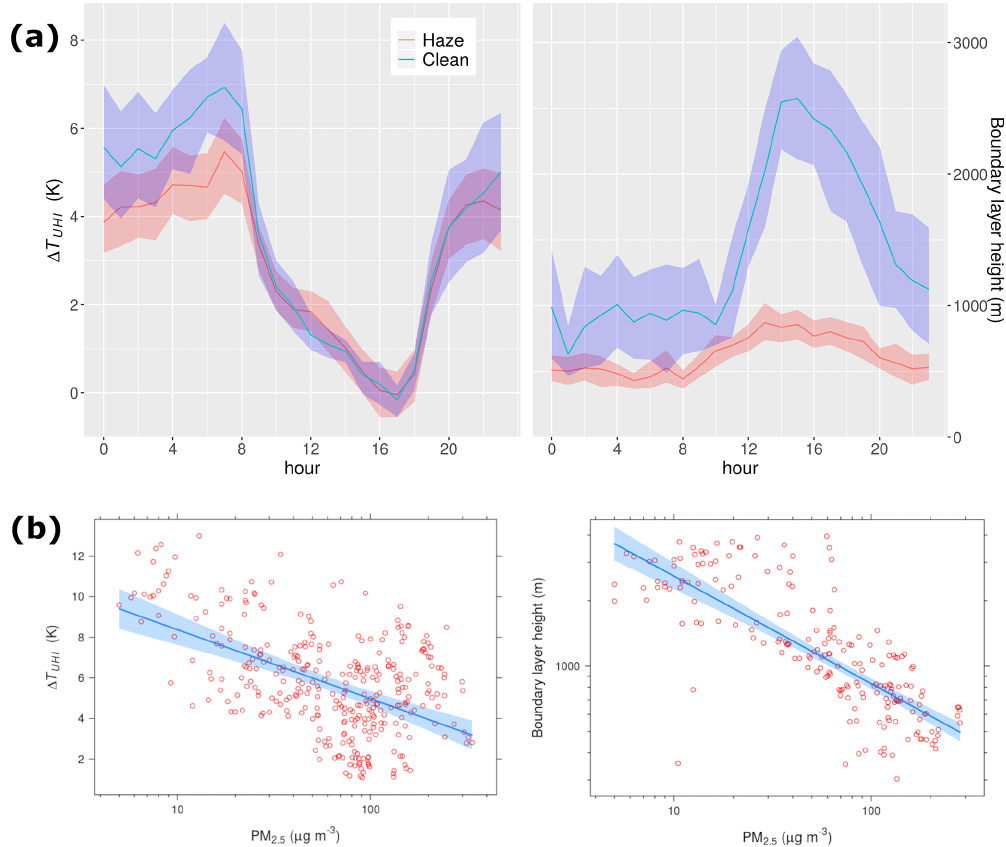
Figure 3. (a) Mean diurnal cycle of the magnitude of an urban heat island ( (cid:49)T UHI ) and boundary layer (BL) height during hazy (30d) and clean conditions (24d) between 6 February and 31 March 2018. The shaded areas are the 95% confidence intervals of the fitted curve. (cid:49)T UHI is calculated as a difference in air temperature between the Beijing University of Chemical Technology (BUCT) and a rural station in southeast of Beijing (Daxing; 39.654 ◦ N, 116.695 ◦ E; see Ma, et al., 2018). (b) Scatterplots of boundary layer height vs. PM 2 . 5 concentration for daytime (14:00–18:00LT – local time; right panel) and urban heat island magnitude ( (cid:49)T UHI ) vs. PM 2 . 5 concentration for nighttime (0:00–8:00LT; left panel). The values where (cid:49)T UHI is under 4K, with low PM 2 . 5 concentrations ( < 40), have been filtered out since those low values of (cid:49)T UHI are presumably caused by phenomena other than haze (e.g., cloudiness). The shaded areas indicate 95% confidence